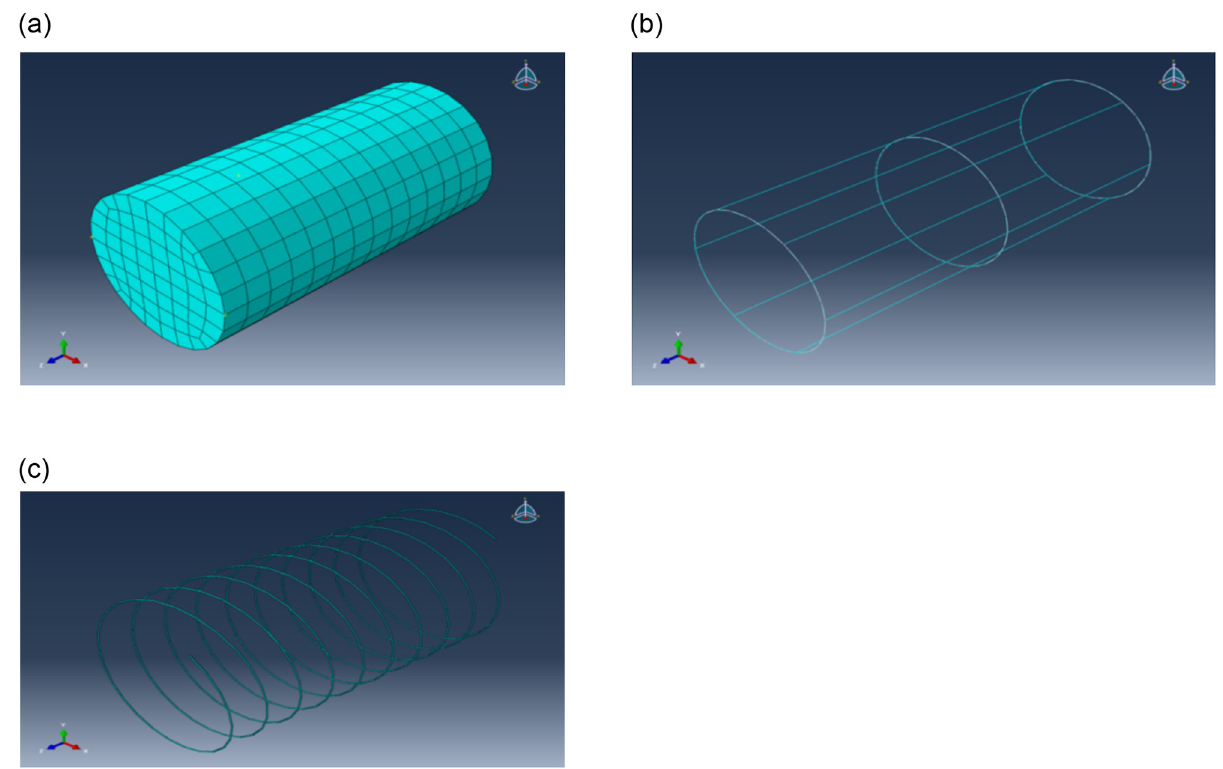
Fig 14. Model diagram of each part. (a) Concrete. (b) Reinforcement cage. (c) SMA wire.